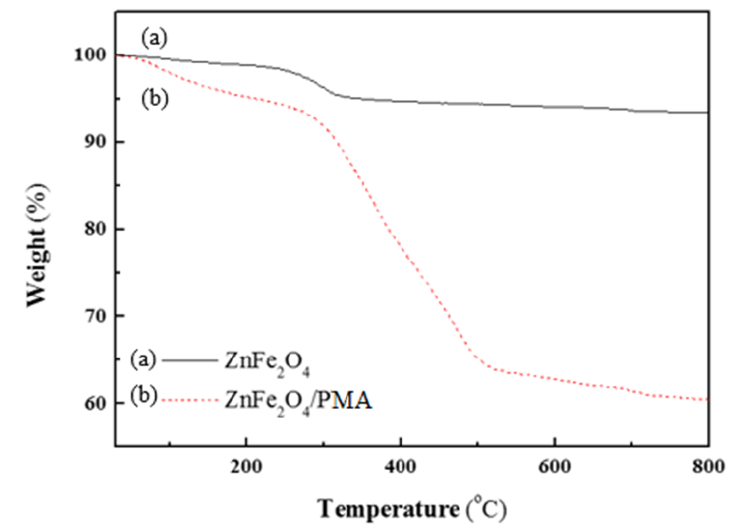
Figure 5. TGA data of ( a ) ZnFe 2 O 4 , and ( b ) ZnFe 2 O 4 /PMA particles.